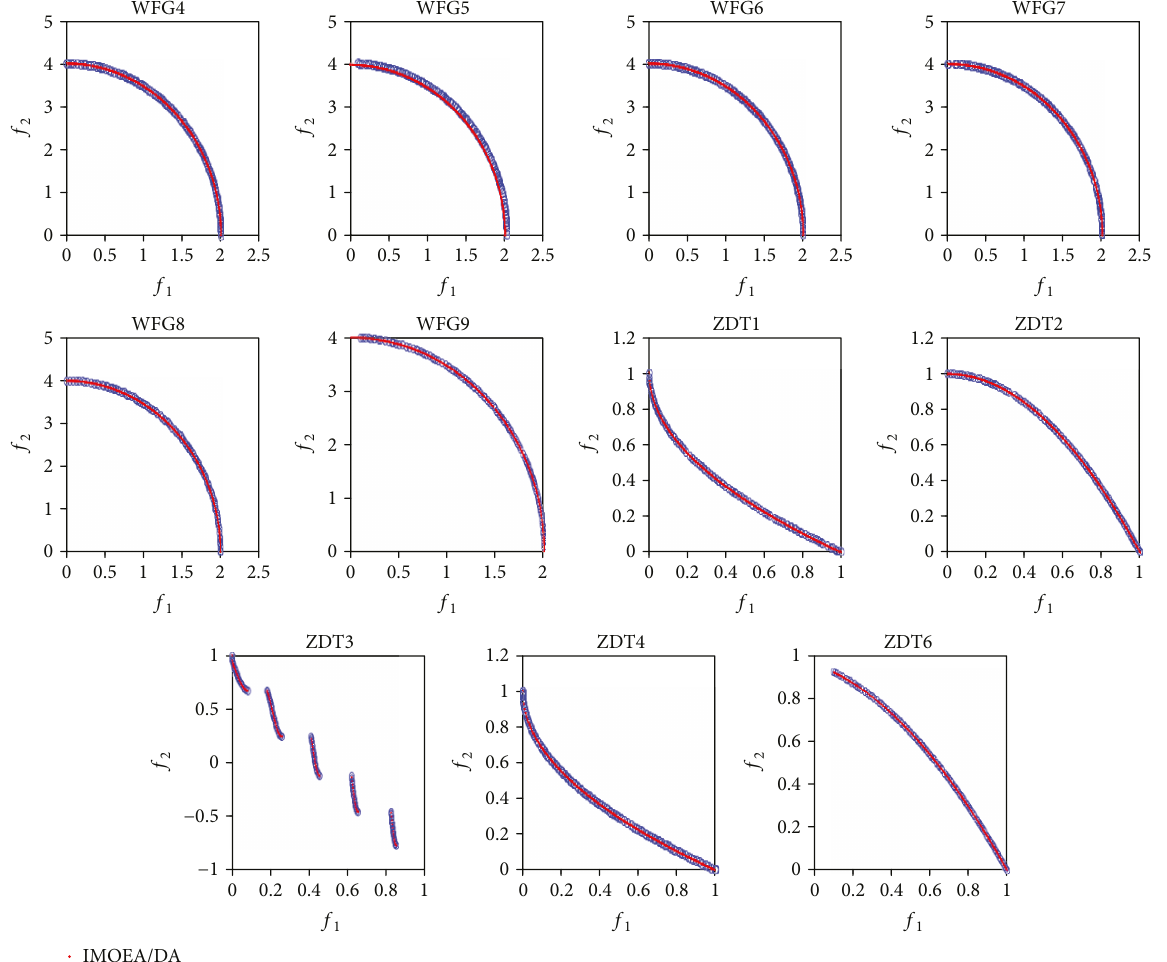
Figure 4: According to the median values of IGD metric, nondominated solutions obtained by IMOEA/DA on WFG4 – WFG9 and fi ve ZDT problems.